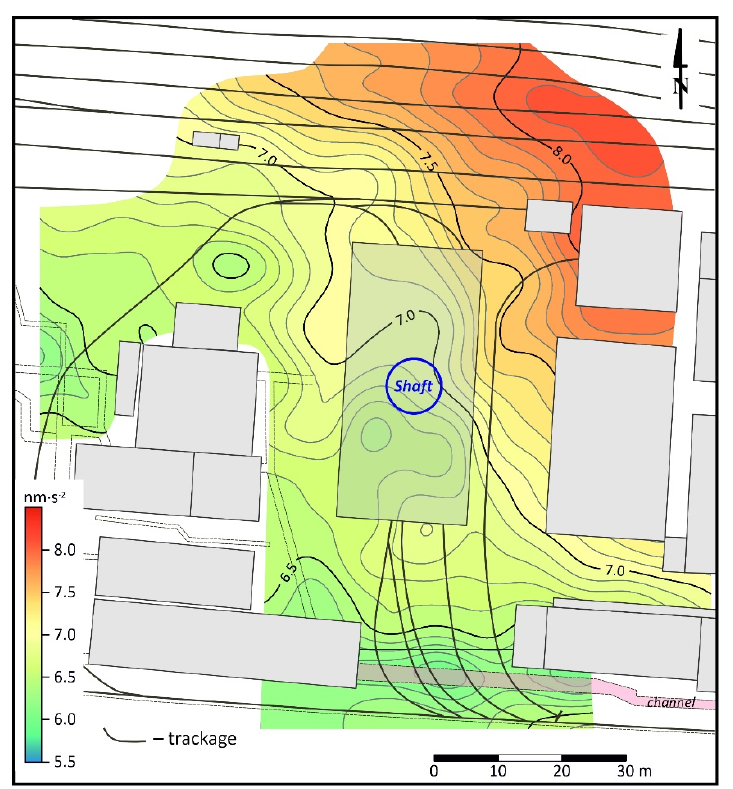
Figure 4. Distribution of Bouguer anomalies with building and mining correction.